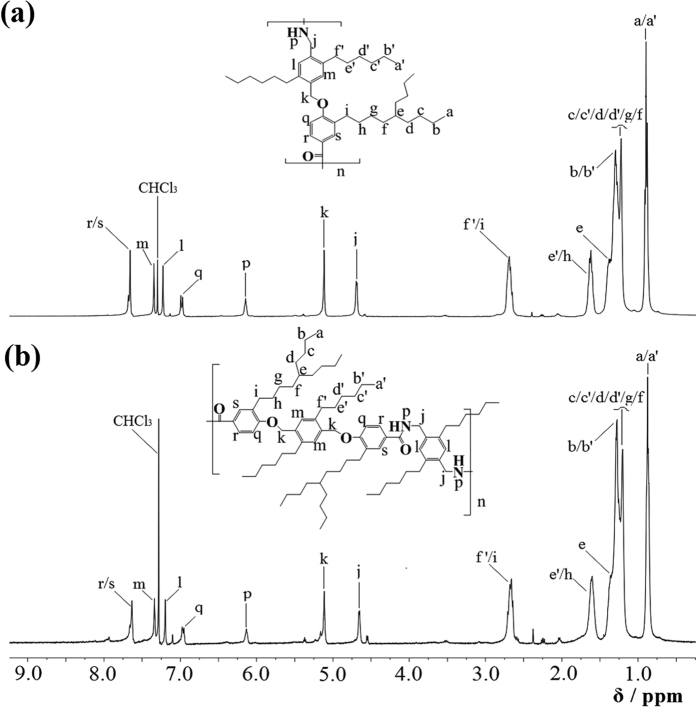
The 1H NMR spectra of (a) ABAB and (b) AABB in chloroform-d.